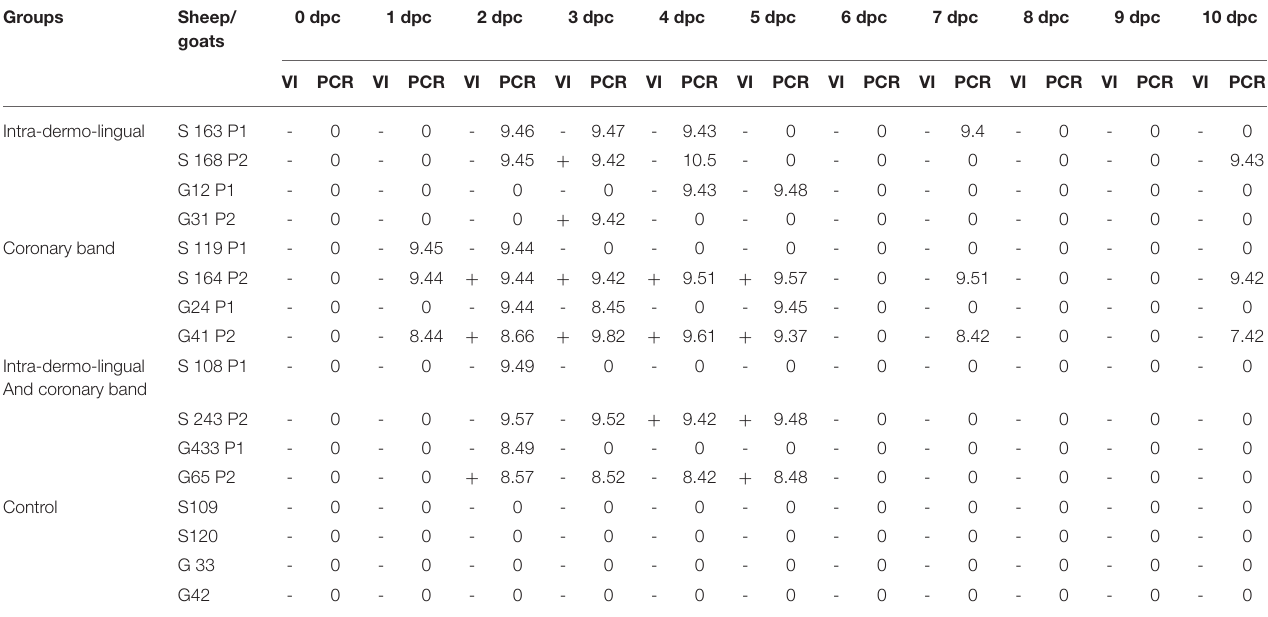
TABLE 2 | Virus isolation and quantification of FMD viral RNA copy numbers (Log 10 RNA copy numbers/ ml of blood) from blood of challenged and control sheep and goats. Groups Sheep/